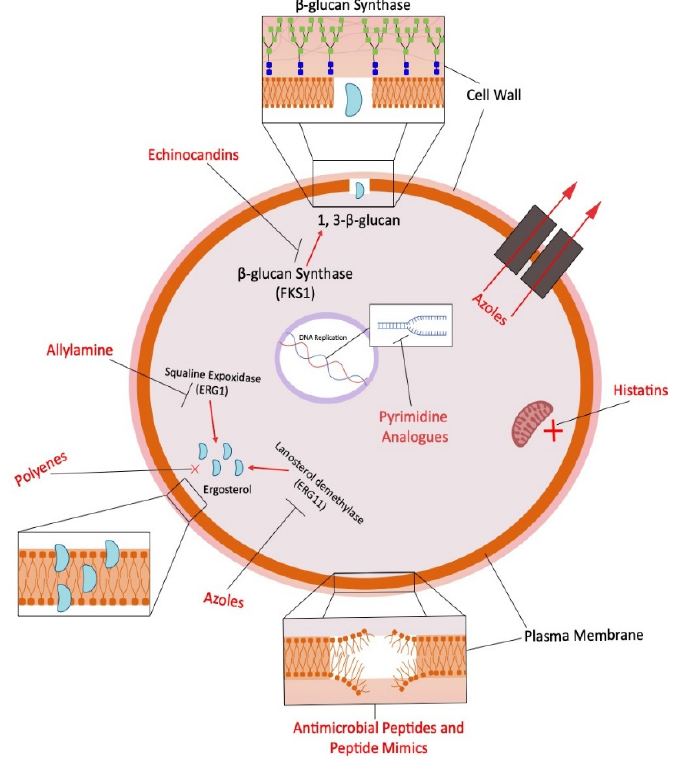
Figure 1. Classes of Antifungal Drugs and Their Overall Mechanism of Action. Drug class names are indicated in red.